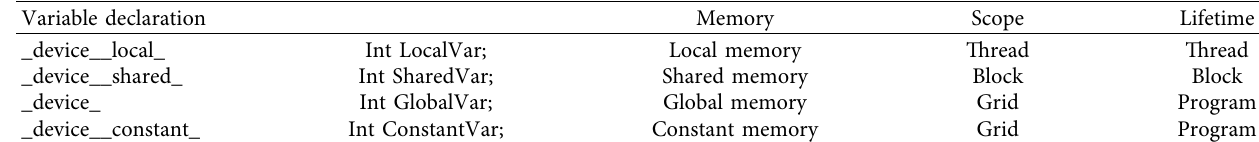
Table 1: CUDA variable description.